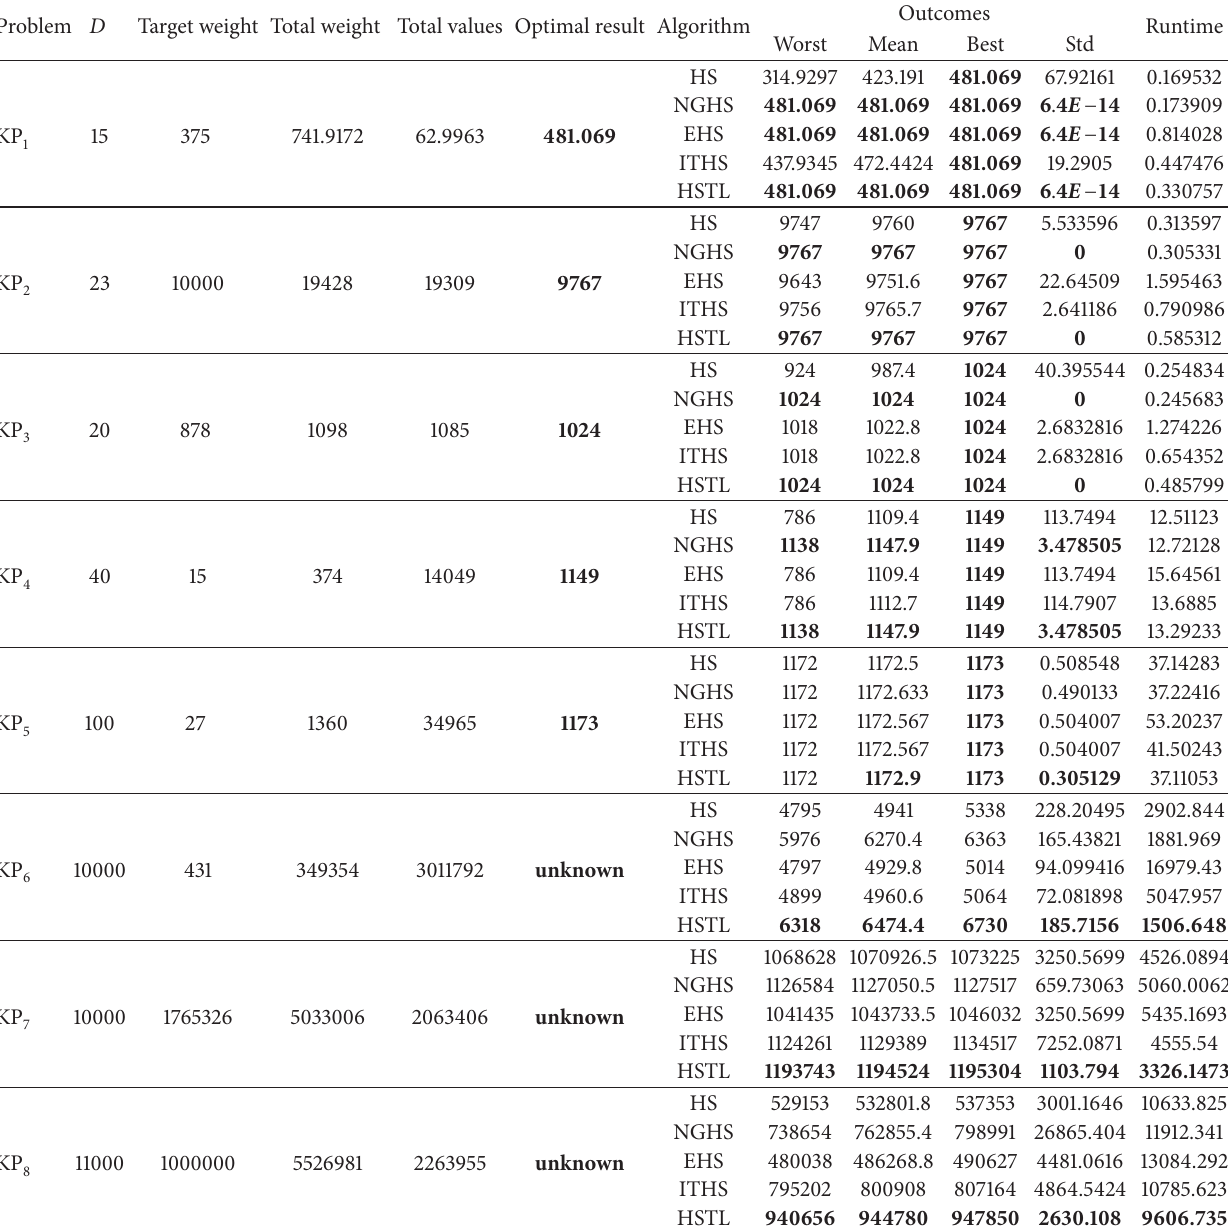
Table 3: The result of 1-dimensional (weight versus value) knapsack problems. Problem